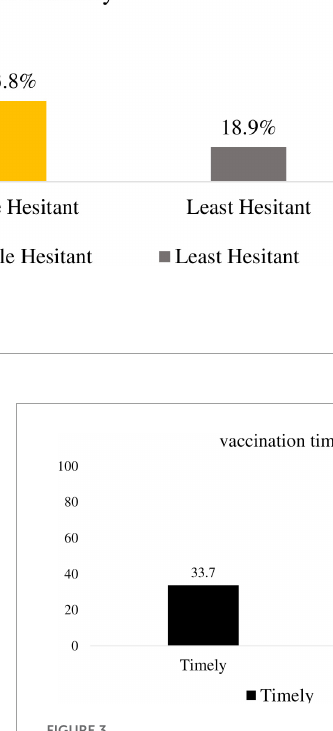
FIGURE3 Vaccination timeliness among children aged 12-23